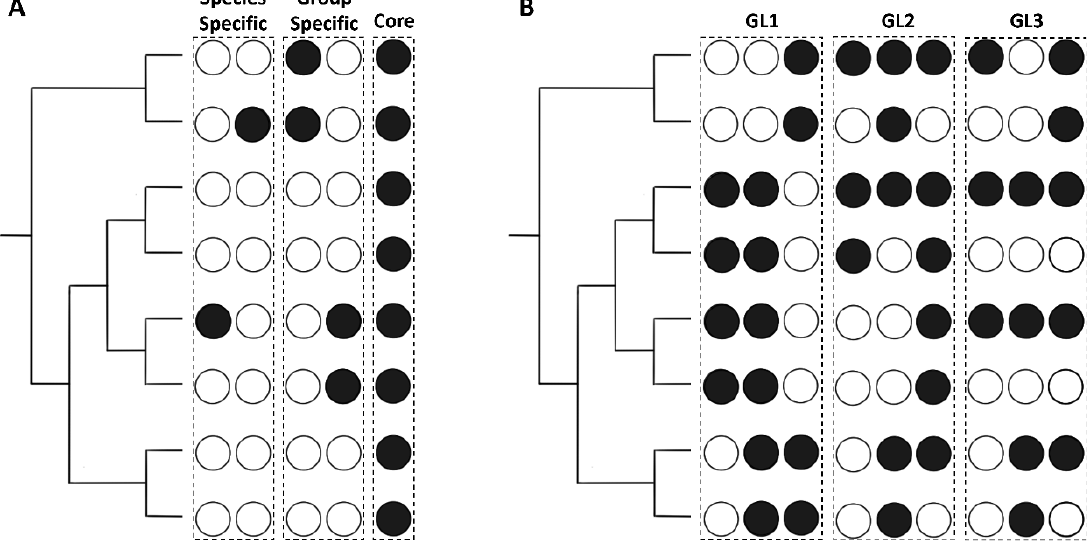
Figure 5. Examples of the categorization scheme used for the EHSs. Circles correspond to the species at the tips of the phylogenies to the right of the figure. Black circles indicate the presence of a homolog in the species, while white circles represent an absence. Instances that meet the conditions for a specific category are grouped within a dashed box and the corresponding group is labeled above. ( A ) shows the instances in which EHSs would be categorized into Species Specific, Group Specific, or Core. ( B ) focuses on the Other group, and gives examples of instances that would be categorized as GL1, GL2, or GL3.